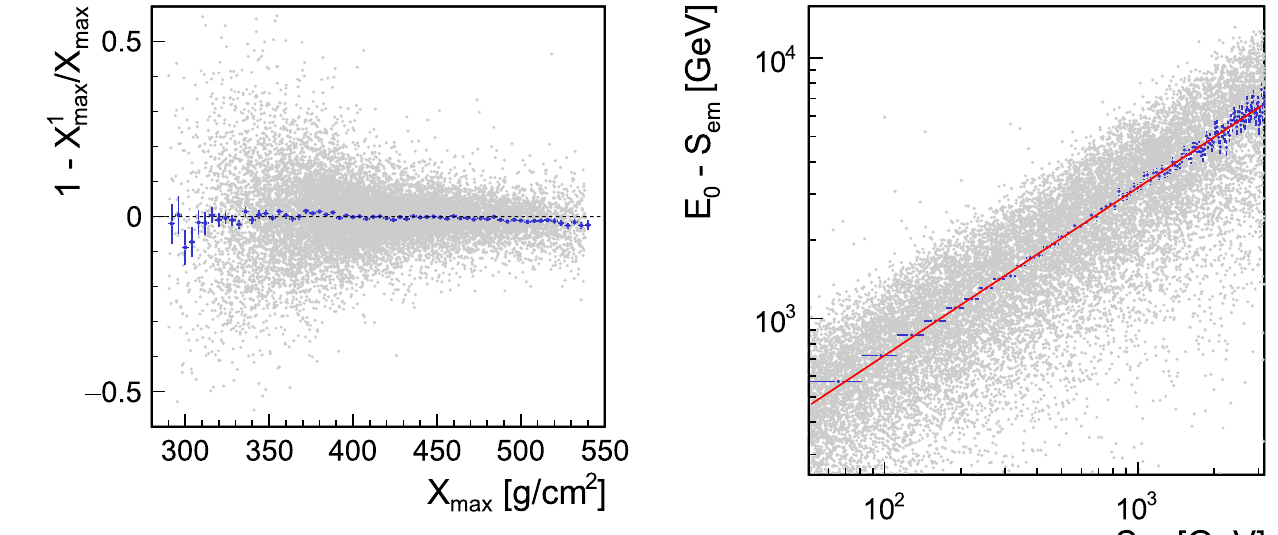
Fig. 8 Normalized deviation of the estimator X 1 max , defined in Eq. 7, from the real X max , as a function of X max (see text for the simulation details)